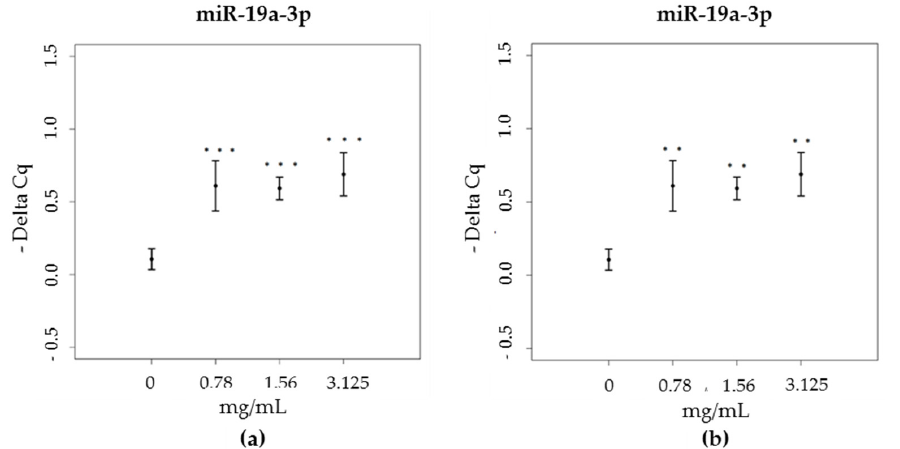
Figure 3. miR ‐ 19a ‐ 3p expression levels (expressed as difference of Cq – Delta ‐ Cq) in HaCat cells, treated with increasing concentrations of ( a ) green propolis extract (0.78–3.125 mg/mL) and ( b ) brown propolis extract (0.78–3.125 mg/mL).